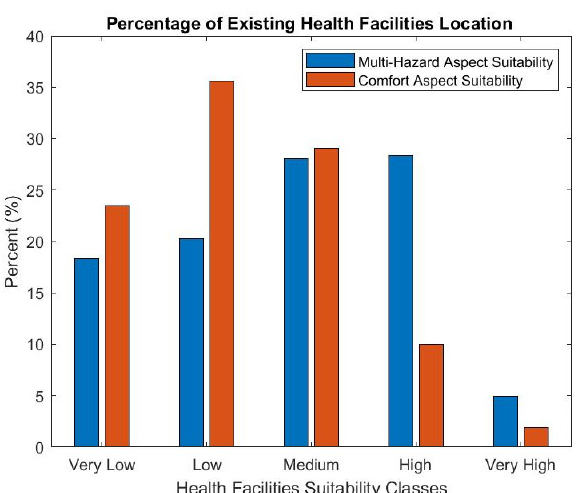
Figure 7 Health Facilities Existing Evaluation (note: very high multi-hazard aspect Suitability means the location has very low